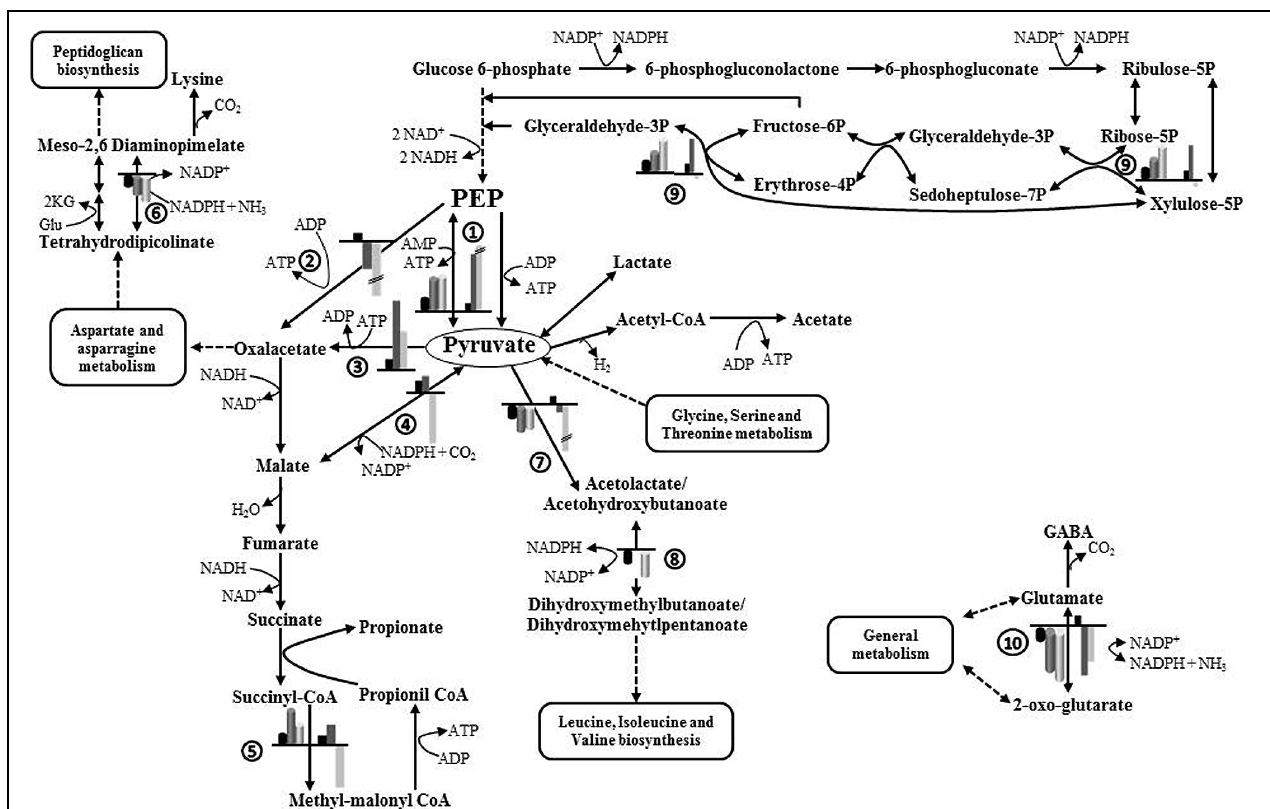
FIGURE 4 | Schematic representation of the main metabolic pathways affected by the availability of carbohydrates added to the culture medium (glucose, EPS E44, and EPS R1) during growth of B. fragilis . Production ratios of enzymes catalyzing different steps in the presence of EPS with respect to glucose are indicated by cylindrical bars. Fold changes in the expression of genes in the presence of EPS with respect to glucose are indicated by rectangular bars. Black bars, glucose; dark gray bars, EPS E44;